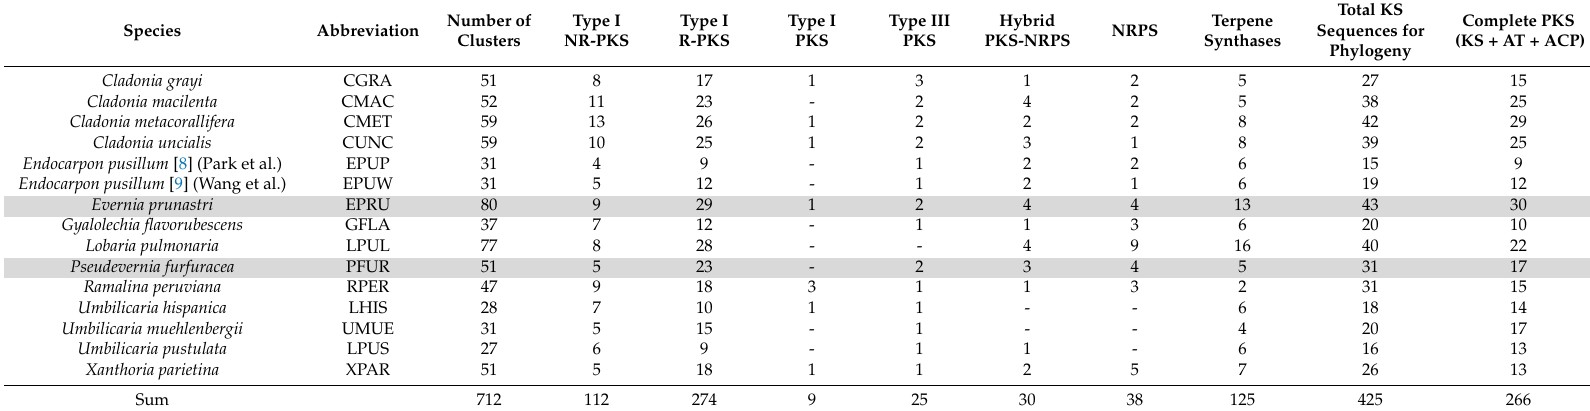
Table 2. Number of biosynthetic gene clusters and main families of secondary metabolite genes found in the genomes of lichen-forming fungi. Total KS Number of Type I Type I Type I Type III Hybrid Terpene Complete PKS Species Abbreviation NRPS Sequences for Clusters NR-PKS R-PKS PKS PKS PKS-NRPS Synthases (KS + AT + ACP) Phylogeny Cladonia grayi CGRA 51 8 17 1 3 1 2 5 27 15 Cladonia macilenta CMAC 52 11 23 - 2 4 2 5 38 25 Cladonia metacorallifera CMET 59 13 26 1 2 2 2 8 42 29 Cladonia uncialis CUNC 59 10 25 1 2 3 1 8 25 Endocarpon pusillum [8] (Park et al.) EPUP 31 4 9 - 1 9 Endocarpon pusillum [9] (Wang et al.) EPUW 31 5 12 - 1 2 1 6 19 12 Evernia prunastri EPRU 80 9 29 1 2 4 4 13 43 30 Gyalolechia flavorubescens GFLA 37 7 12 - 1 1 3 6 20 10 Lobaria pulmonaria LPUL 77 8 28 - - 4 9 16 40 22 Pseudevernia furfuracea PFUR 51 5 23 - 2 3 4 5 31 17 Ramalina peruviana RPER 47 9 18 3 1 1 3 2 31 15 Umbilicaria hispanica LHIS 28 7 10 1 1 - - 6 18 14 Umbilicaria muehlenbergii UMUE 31 5 15 - 1 - - 4 20 17 Umbilicaria pustulata LPUS 27 6 9 - 1 1 - 6 16 13 Xanthoria parietina XPAR 51 5 18 1 1 2 5 7 26 13 Sum 712 112 274 9 38 125 425